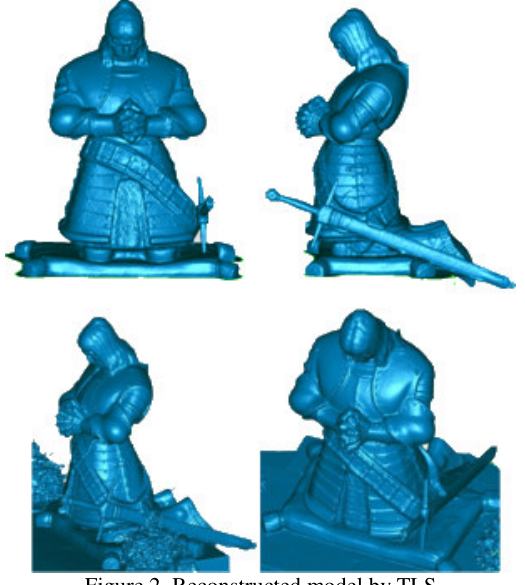
Figure 2. Reconstructed model by TLS